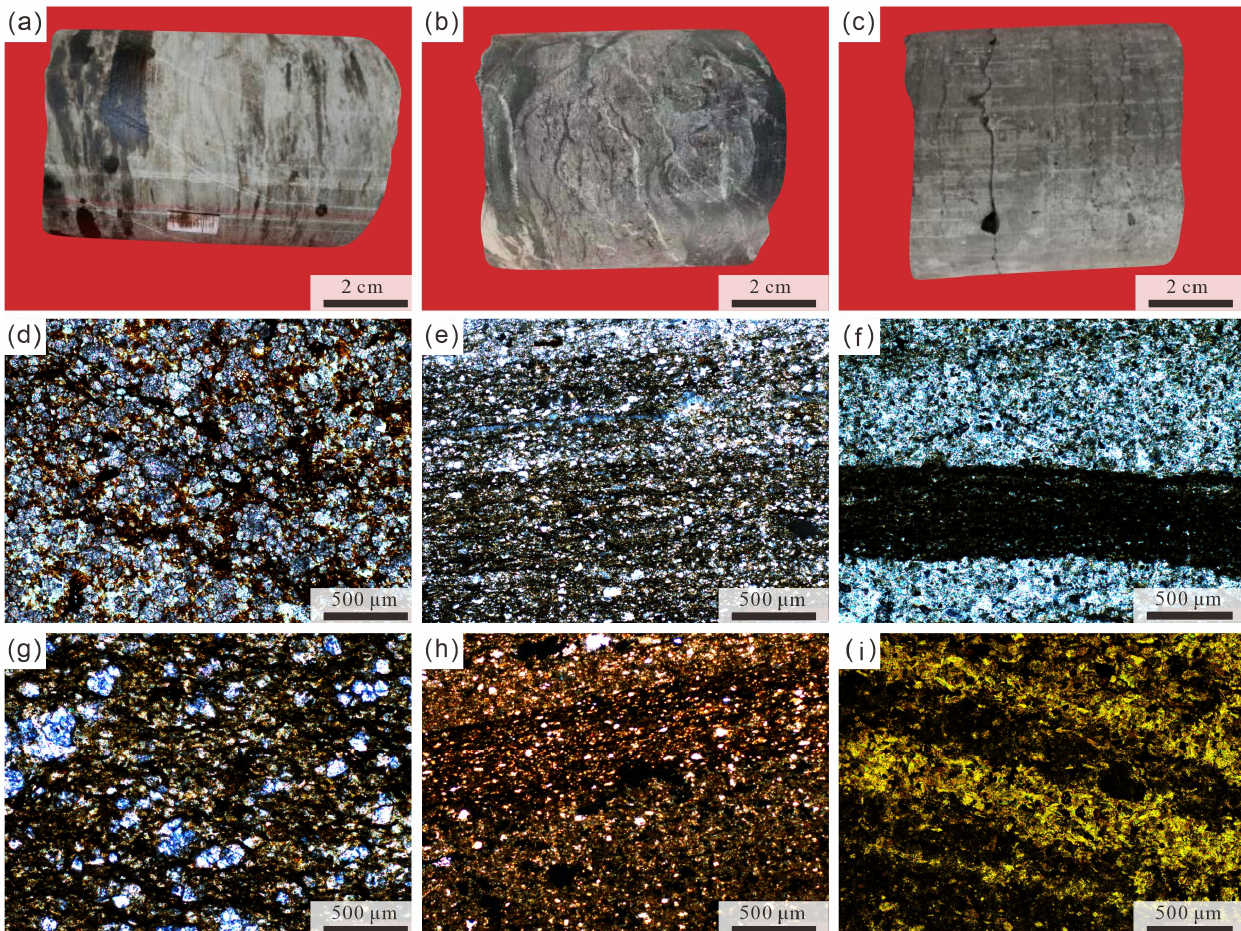
Figure 5. Reservoir rock types of the Permian Lucaogou Formation in the Jimsar Sag. ( a ) Gray calcareous siltstone, developmental wavy bedding, J36-4, 4346.13 m; ( b ) gray sandstone, filled calcite strip, developmental wave layering, kneading structure, J10025, 3567.5 m; ( c ) green argillaceous siltstone, developmental stylolite, J10025, 3618.1 m; ( d ) lamellar and blocky interaction of mixed fine-grained rock, J36-4, 4373.46 m, PPL; ( e ) lamellar mixed fine-grained rock, J36-4, 4376.48 m, PPL; ( f ) lamellar dolomitic siltstone, J36-4, 4340 m, PPL; ( g ) block-like, fine, calcareous sandstone, J36-4, 4369.5 m, PPL; ( h ) block limestone, J36-4, 4345.36 m, PPL; ( i ) lamellar argillaceous dolomite, J36-4, 4353.33 m. PPL: plane-polarized light.